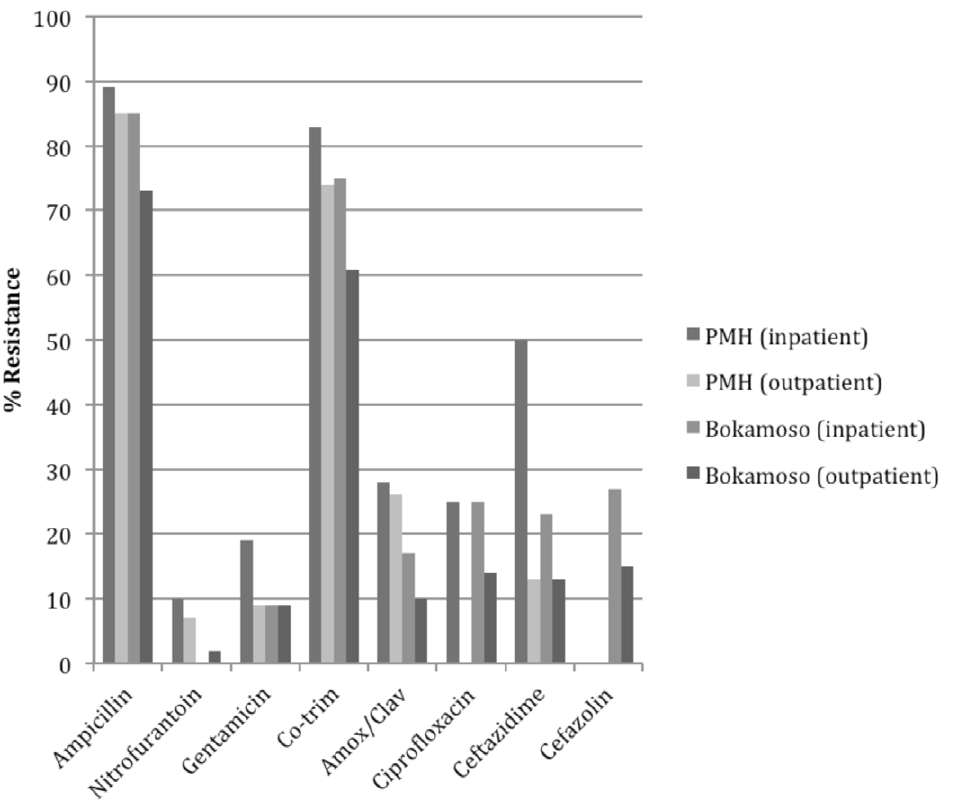
Figure 2. Antimicrobial resistance patterns of E. coli isolates. * *Less than 15 samples analyzed for these antimicrobials as noted: BPH- Inpatients (all antibiotics), PMH-Outpatients (ciprofloxacin, ceftazidime), PMH-Inpatients (ciprofloxacin,